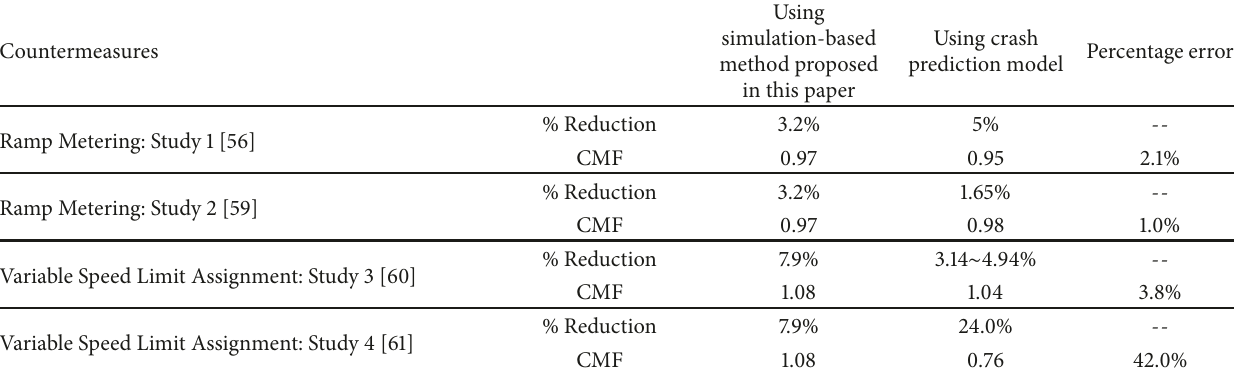
Table 5: Validation of proposed simulation-based method for estimating